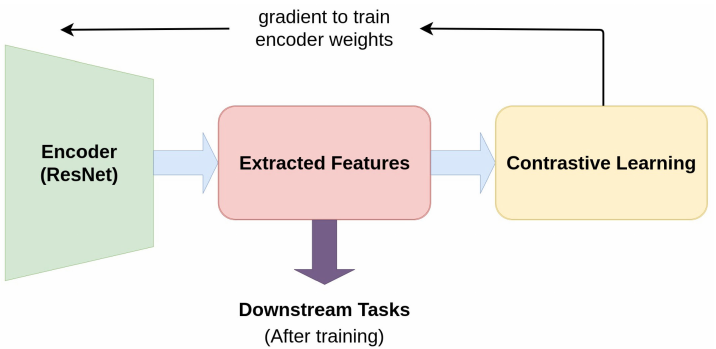
Figure 15. Training an encoder and transferring knowledge for downstream